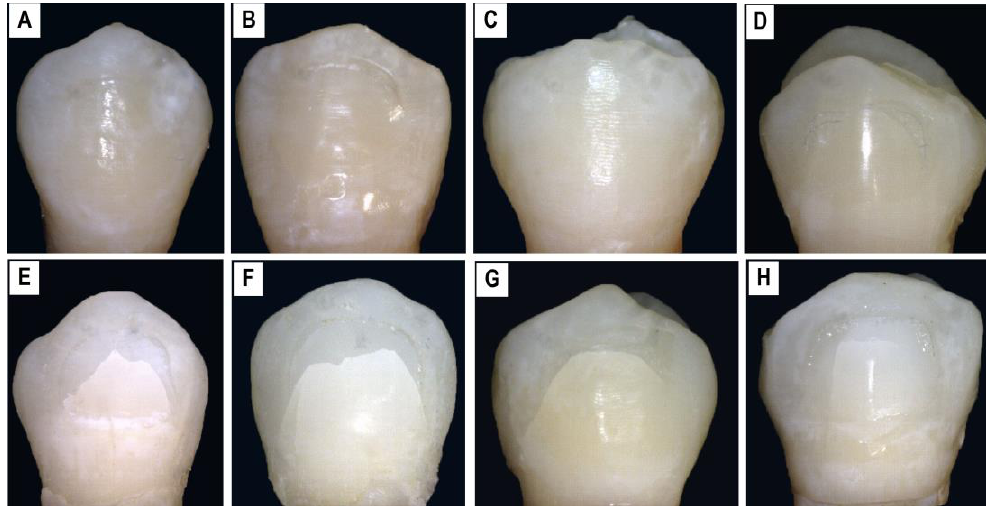
Figure 2: Digital microscope photographs of debonded specimens. A-D: Etched with CaP paste; the enamel surfaces appear smooth and unharmed with minimal or no adhesive remnants. E-H: etched with 37% PA; enamel surfaces have noticeable damage. Bracket debonding was accomplished after 24 h (A, B, E, F) and after 30 d (C, D, G, H). Discussion